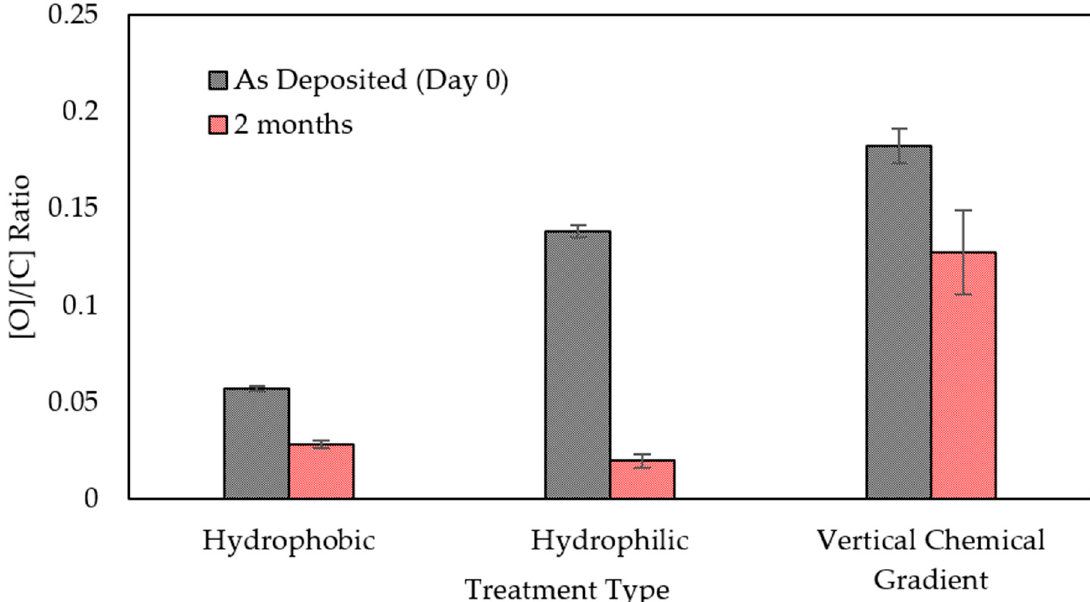
Figure 5. Aging of the coating observed thanks to the [O] / [C] ratio of PICVD (Photo-initiated chemical vapor deposition)-treated SS-CNTs (carbon nanotube forest on stainless steel grids) as deposited and after 2 months.